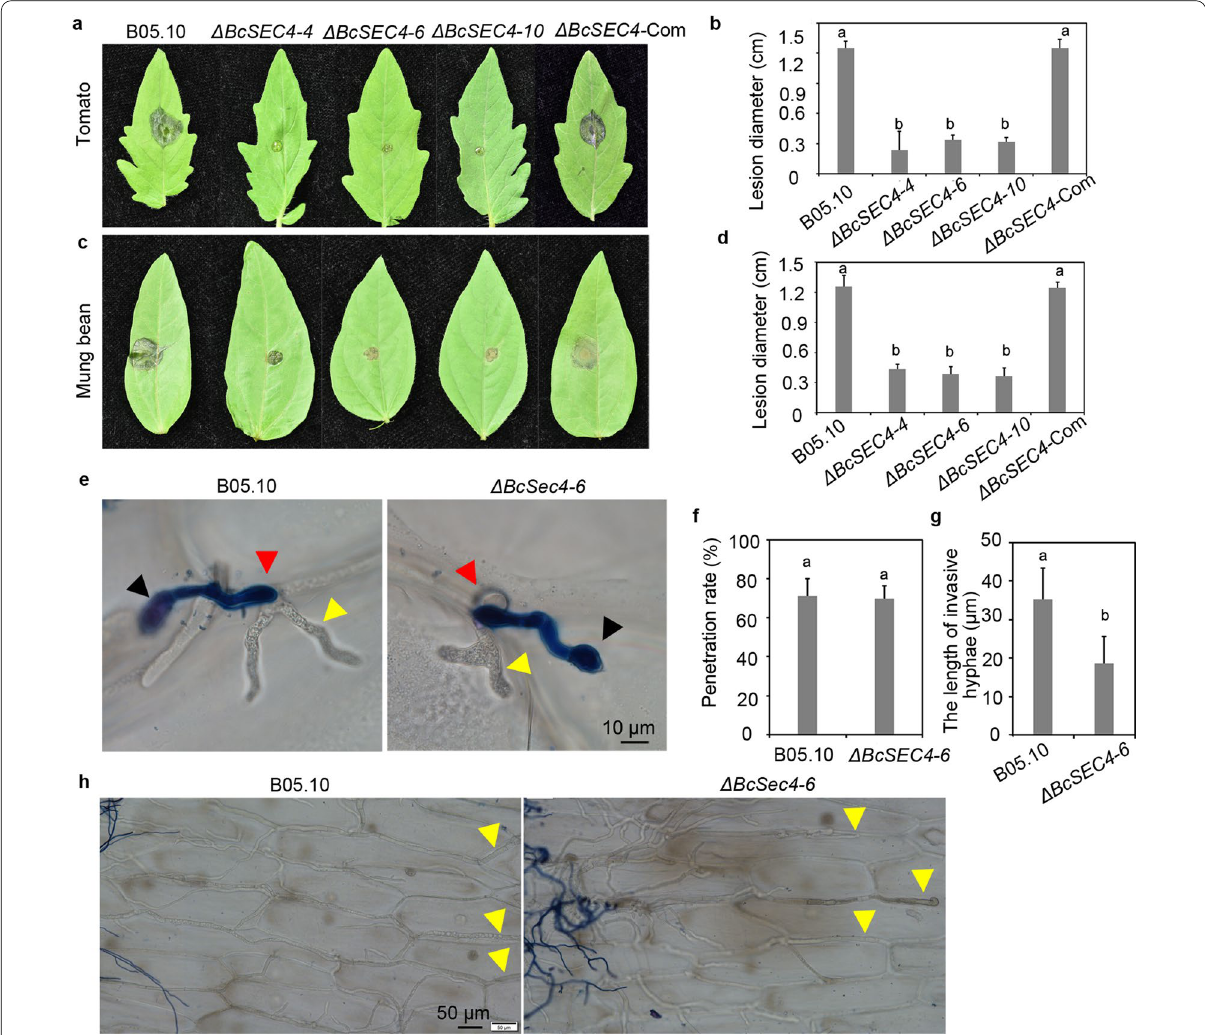
Fig. 5 BcSEC4 is required for full virulence of B. cinerea . Phenotypes of tomato ( a ) and mung bean leaves ( b ) after drop‑inoculated with conidial suspensions (1 10 5 conidia/mL) of B05.10 and the ΔBcSEC4 mutant for 3 days. Column diagram showing lesion size on leaves of tomato ( c ) and × mung bean ( d ) corresponding to a and b . e Penetration assay performed on onion epidermis and observed under a microscope at 12 hpi. Red arrows: appressoria; Black arrows: conidia; Yellow arrows: invasive hyphae. f Relative penetration rate on onion epidermis at 12 hpi. At least 50 infection hyphae were counted for each strain. g The lengths of invasive hyphae measured at 12 hpi. h The expansion of B05.10 and the ΔBcSEC4 mutant in onion epidermal cells (yellow arrows) observed under a microscope at 36 hpi. All data are represented as means (SDs) from three independent experiments. Different letters indicate statistically significant differences ( P <